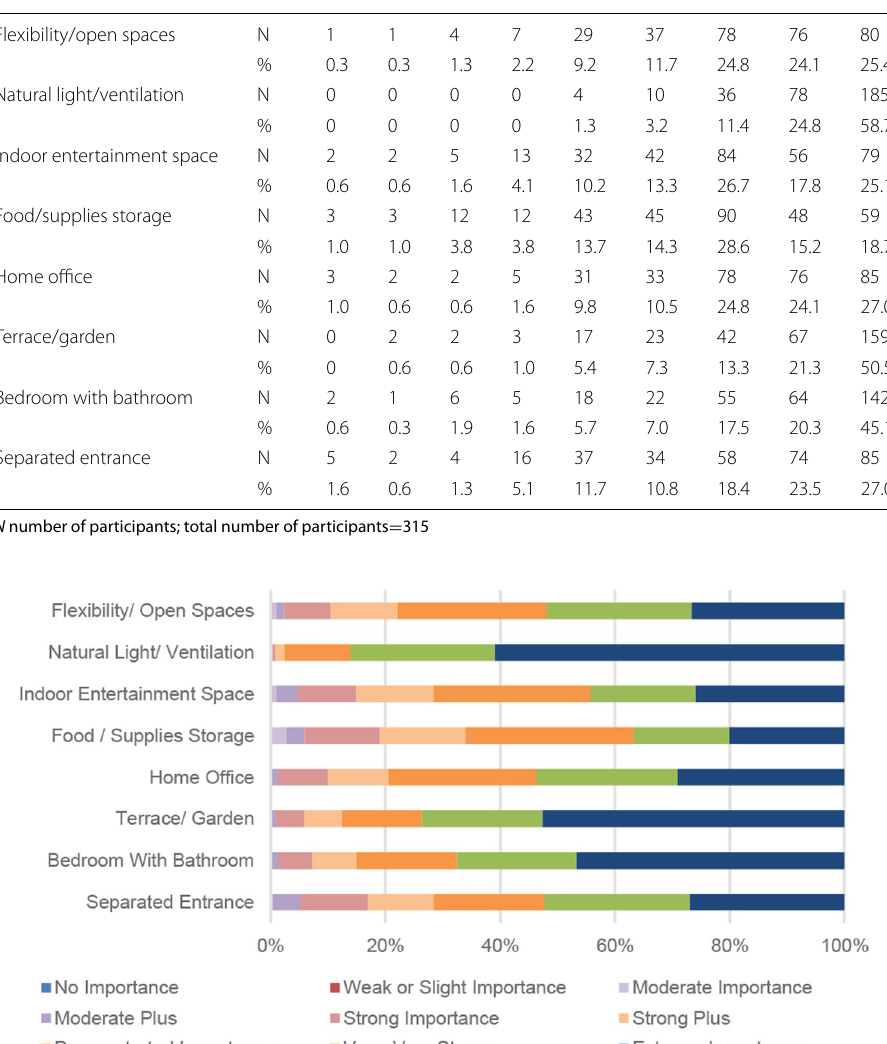
Fig. 3 Participants’ perceptions of the importance of the suggested home design indicators during and post-COVID-19. Ref: